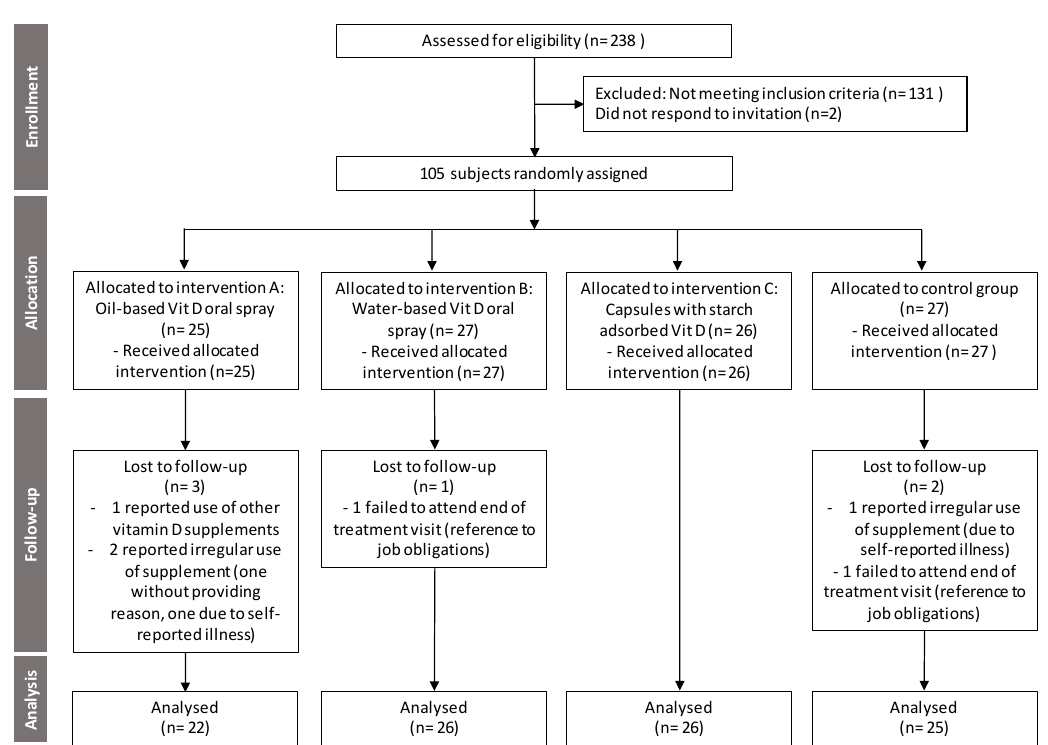
Figure 1. CONSORT (Consolidated Standards of Reporting Trials) flow diagram showing trial design and subjects’ assignment and progression through the trial.